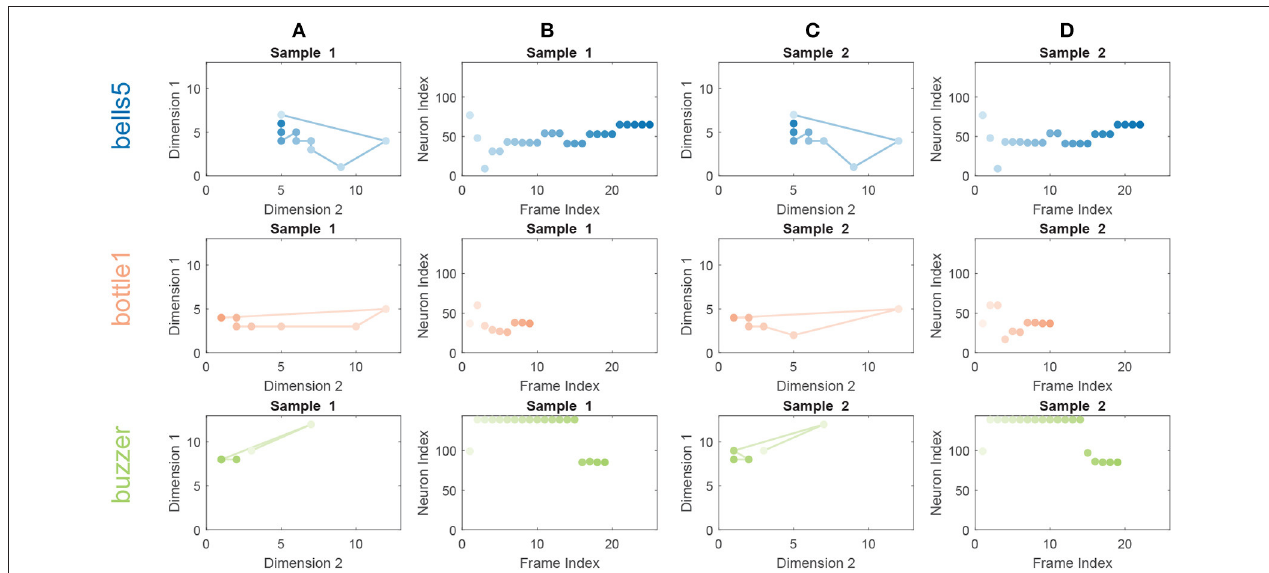
FIGURE 4 | BMU activation trajectories of the SOM (A,C) and BMU activation sequences (B,D) for randomly selected sound samples from classes “bell5” (Row 1), “bottle1” (Row 2) and “buzzer” (Row 3) of a trained 12 12 SOM on the RWCP dataset. For BMU activation trajectories, the lines connect activated BMUs from × frame to frame. The activated BMUs are highlighted from light to dark over time. For BMU activation sequences, the neurons of the SOM are enumerated along the y-axis and color matched with neurons in the BMU activation trajectories. The low intra-class variability and high inter-class variability for the BMU activation trajectories and sequences are